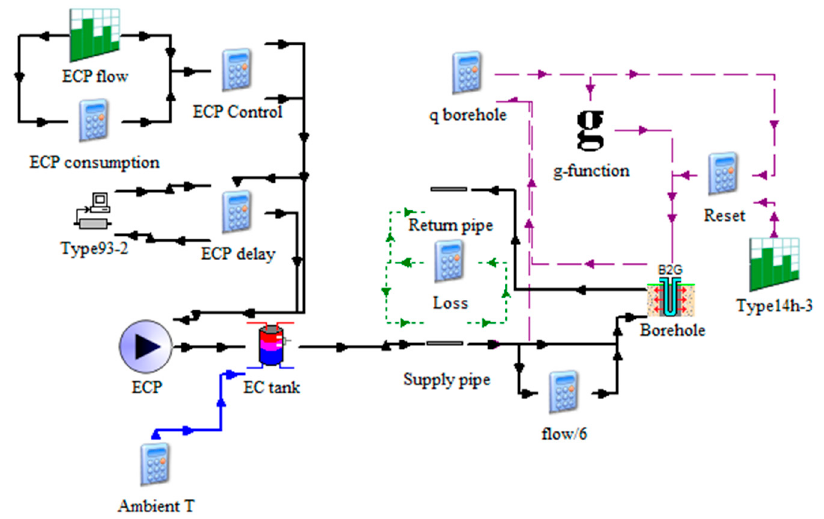
Figure 6. EC components with GSHE model in TRNSYS.